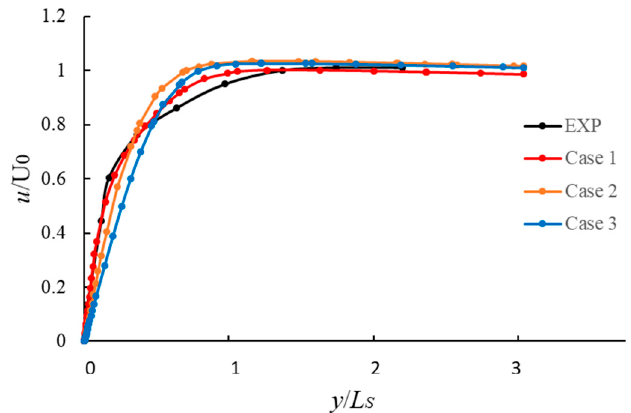
Figure 4. Boundary layer velocity profiles calculated by three different mesh sizes (steady condition).